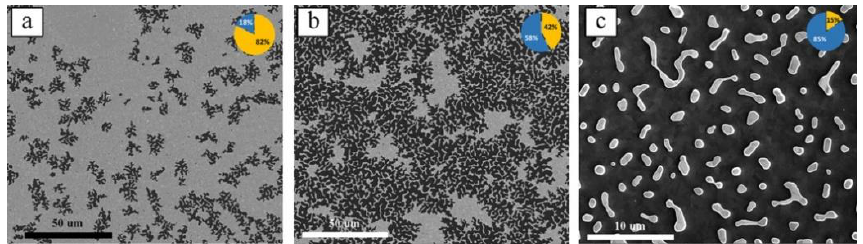
Figure 4. ( a ) SEM top view image of Au annealed for 2 h at 450 °C (the inset shows surface area ratio of Au (yellow) to TiO 2 (blue)); and ( c ) Au-dTiO annealed at 450 °C for 6 h. Reproduced from [71] with permission from Elsevier, 2018.